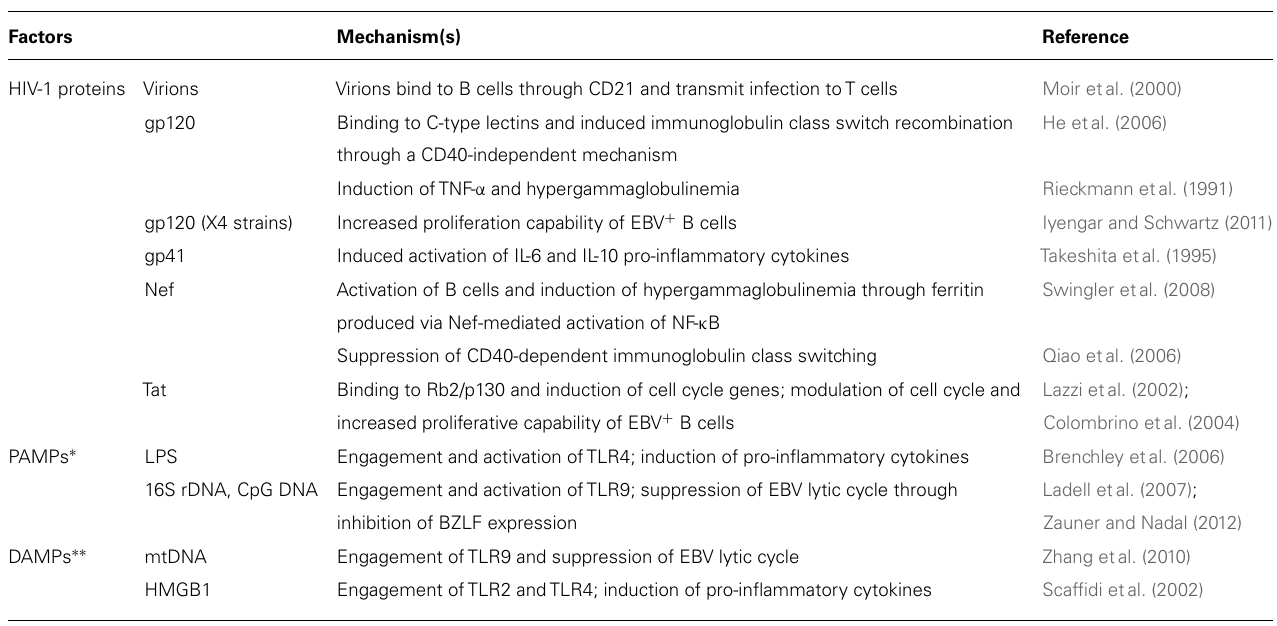
Table 1 | Factors involved in HIV-1 and EBV interplay through B cell